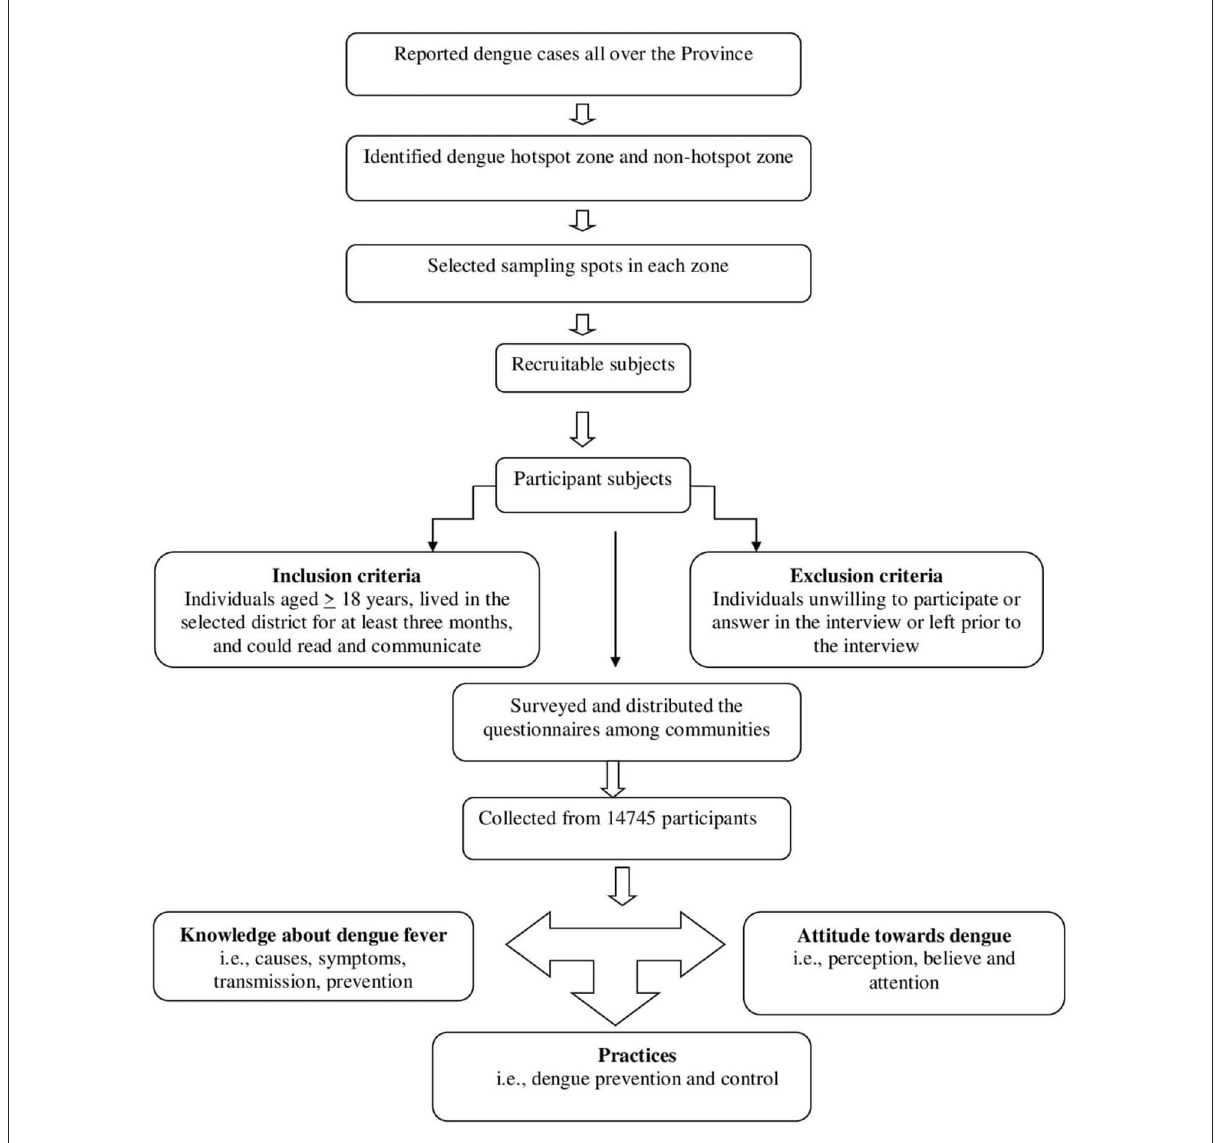
FIGURE2 A conceptual framework diagram for a KAP-based (Phase II)